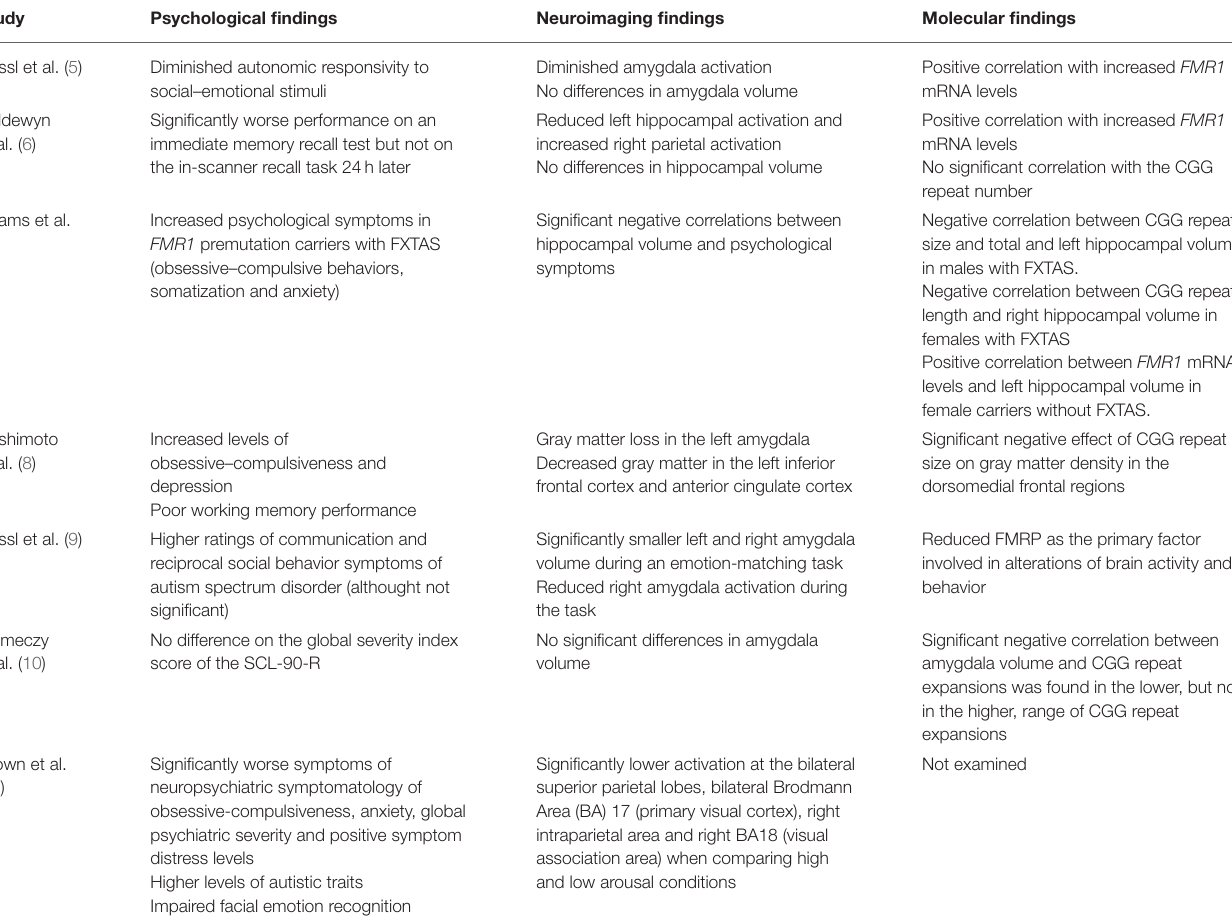
TABLE 3 | Summary of the psychological, neuroimaging and molecular findings reported in FMR1 premutation carriers compared to control population in the papers